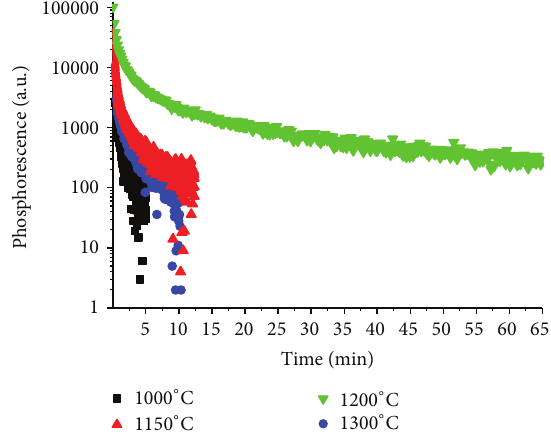
Figure 6: Decay time curves of aluminate/aluminosilicate powders after excitation with UV light at 365